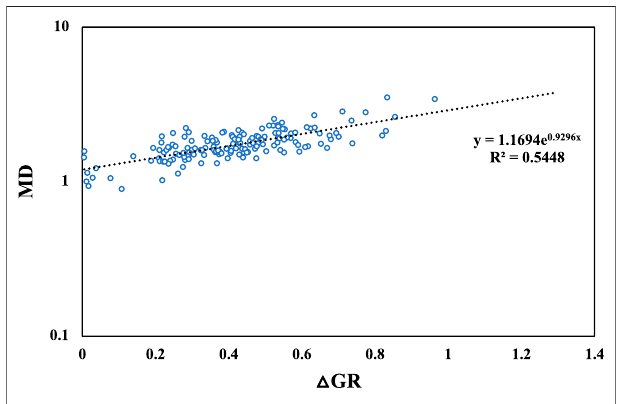
FIGURE 5 | Cross plot of Δ GR and median grain size.